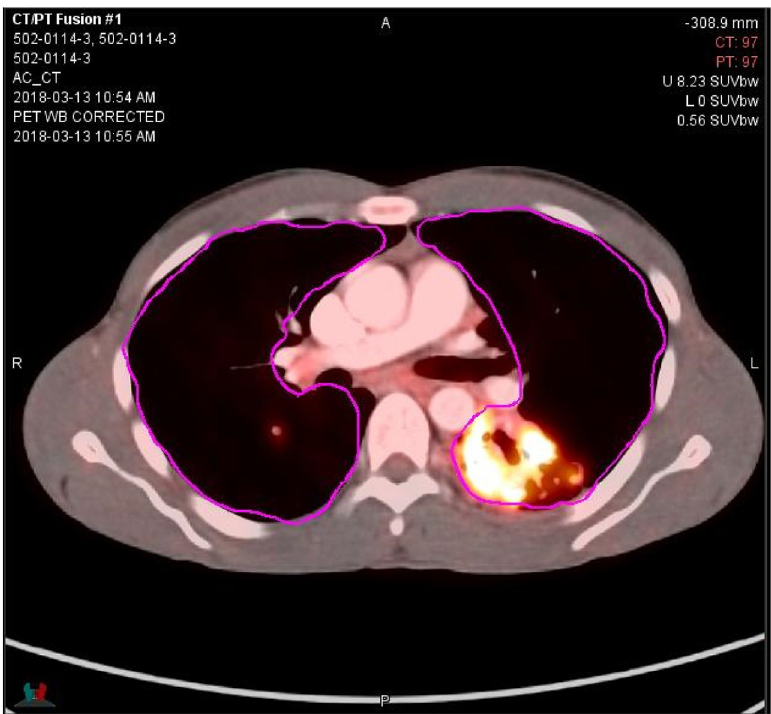
Fig 2. Representative PET/CT fused image. Gray scale indicates CT radiodensity; colored scale indicates PET glycolytic activity. Pink lines indicate limits of selected region of interest.